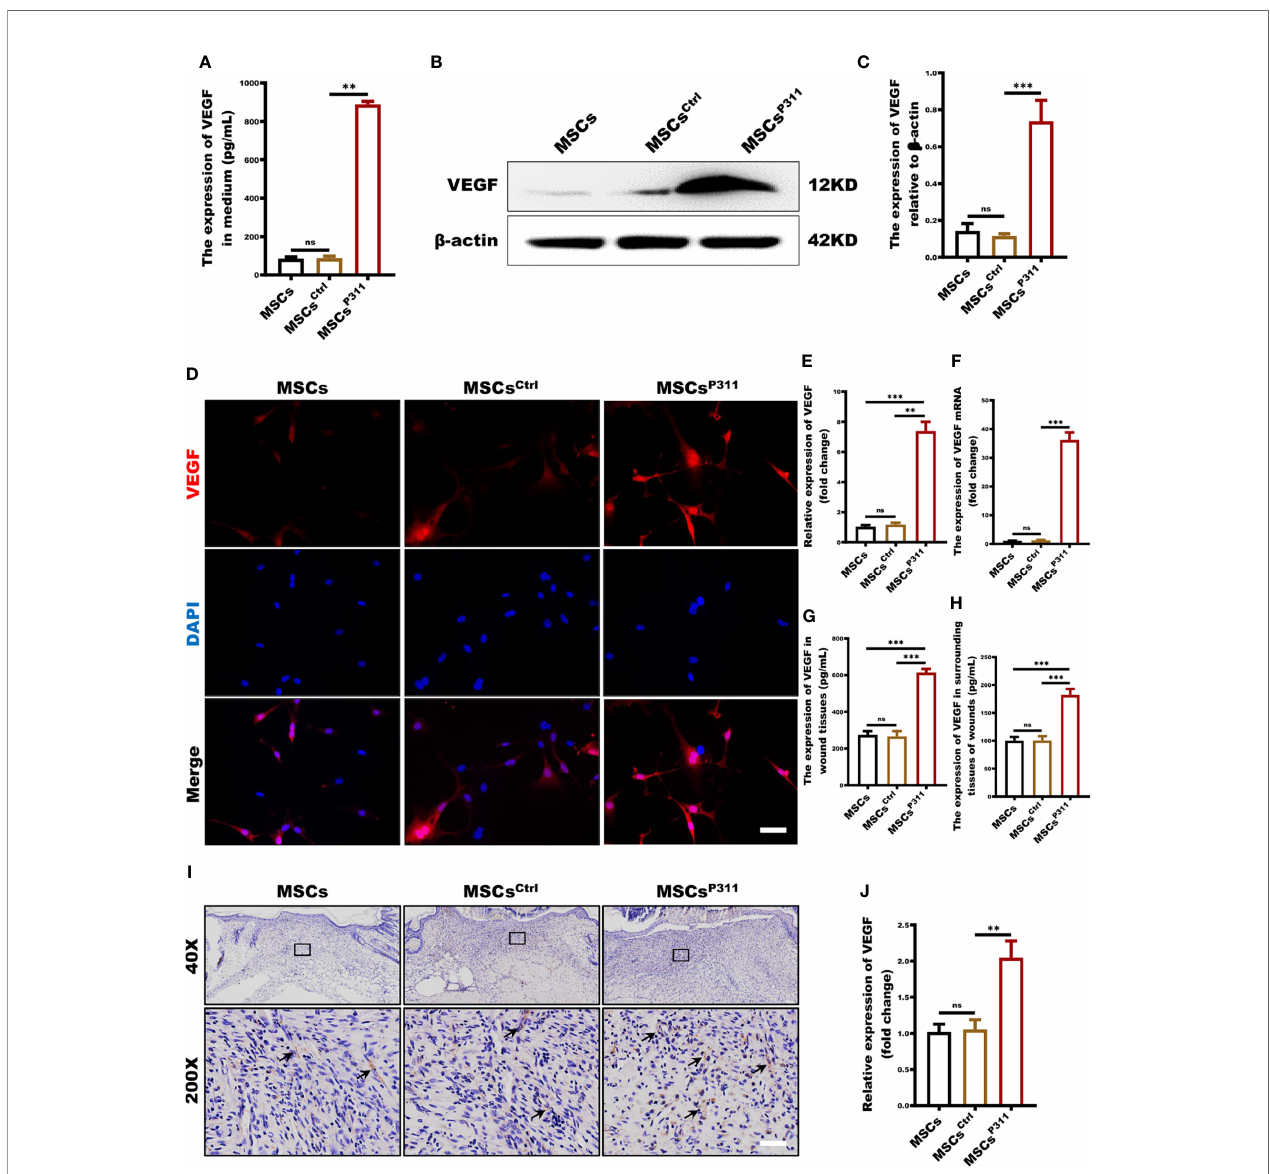
FIGURE 4 | P311 up-regulates pro-angiogenesis cytokine VEGF secretion of MSCs. (A) The extracellular secretion of VEGF in MSCs, MSCs Ctrl and MSCs P311 was examined by ELISA assays. (B – G) The regulation of P311 on VEGF expression of MSCs was estimated by identifying the extracellular secretion, intracellular expression, and mRNA transcription levels of VEGF in MSCs, MSCs Ctrl and MSCs P311 . (B – E) The intracellular expression of VEGF in MSCs, MSCs Ctrl and MSCs P311 was detected by Western blot and confocal microscopy. (B, C) Representative immunoblotting images for VEGF in MSCs, MSCs Ctrl and MSCs P311 were shown (left panel), and the gray value of VEGF was statistically analysed (right panel). (D, E) Representative confocal images for VEGF in MSCs, MSCs Ctrl and MSCs P311 were shown (left panel), and the MFI value of VEGF was statistically analysed (right panel). Scale bar: 100 µm. (F) The mRNA transcription levels of VEGF in MSCs, MSCs Ctrl and MSCs P311 were identi fi ed by qRT-PCR. (G – J) The expression of pro-angiogenesis cytokine in wound tissue post-injury was evaluated by assessing the content of VEGF in mice with MSCs, MSCs Ctrl , MSCs P311 treatment (n=3/group). Data are representative of at least three independent experiments and represent mean ± SD of indicated number of mice per group. (ns, no statistical signi fi cance; **P < 0.01; ***P <